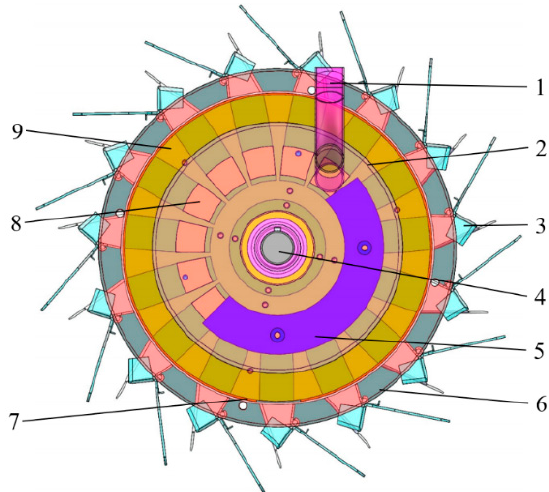
Figure 3. Structure diagram of the hole sower. 1. Seed guide; 2. Fixed disc; 3. Duckbill; 4. Shaft; 5. Seed guard; 6. Moving disc; 7. Retaining ring; 8. Seed divider; 9. Seed